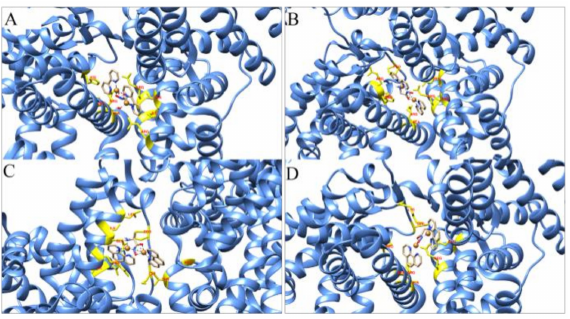
Figure 7. The docking results of BSA and complexes 1 – 4 are A – D